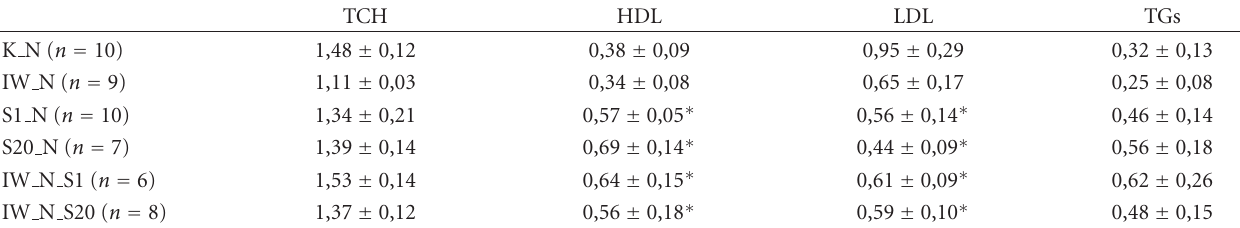
Table 1: Total cholesterol (TCH), HDL-cholesterol, LDL-cholesterol, and triglycerides (TGs) (mean ± SD) in rats fed normocholestero- laemic diet (mmol/l).